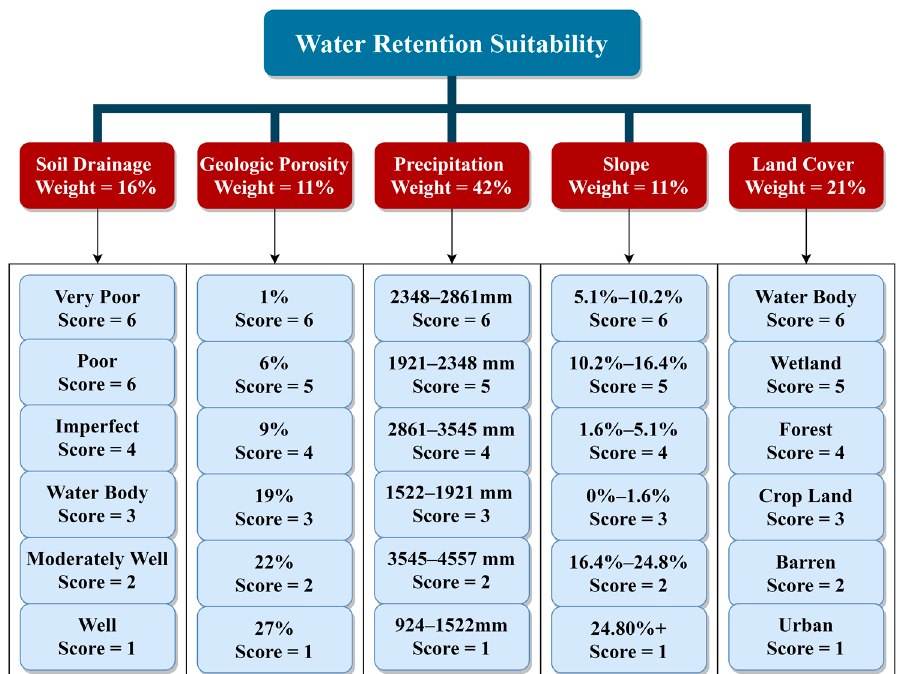
Figure 6. Water retention suitability hierarchy.